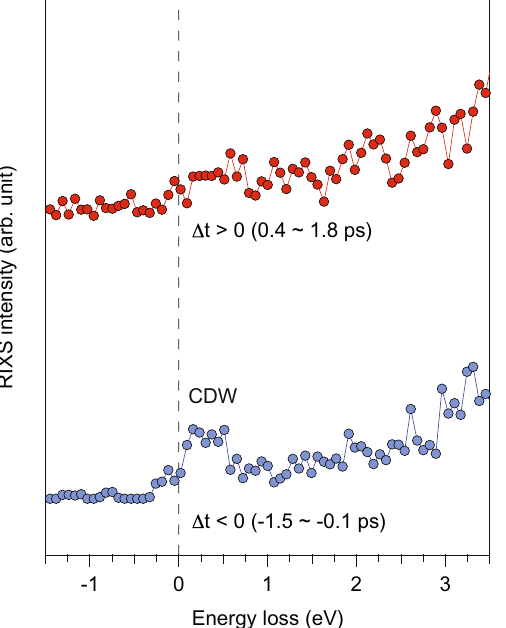
Figure 3. Time-resolved RIXS on TiSe 2 . The RIXS spectra before (blue) and after (red) time zero with a temporal bin size of 1.4 ps. The dashed line indicates the zero-energy loss. The diminished intensity of the CDW peak after time zero indicates the melting of CDW order by the optical pump